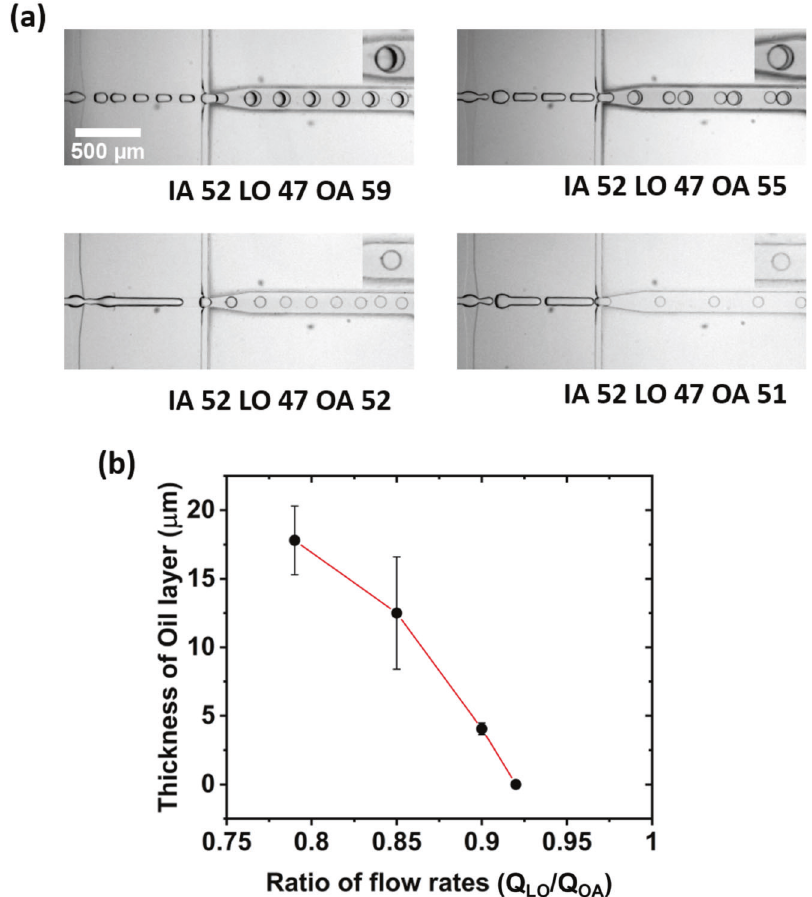
Fig. 3 Manipulation of pressure-induced fl ow rates for reduced oil content and ultra-thin shells. a High-speed camera images of the micro fl uidic liposomal production process to reduce the oil thickness. Inserts: enlarged images of individual double emulsions. From the top left to the bottom right corner, the oil thickness has been reduced by gradually tuning the fl ow rates of the OA (outer aqueous solution). Pressures for each channel are given in mbar. b Plot showing the thickness of the oil layer that is reduced from 17 ± 2 to 12 ± 4 µ m, 4 ± 0.5 µ m and fi nally to optically non-detectable amounts by changing the fl ow rate ( Q ) ratios. Error bars are taken from the standard deviation of the mean ( n >